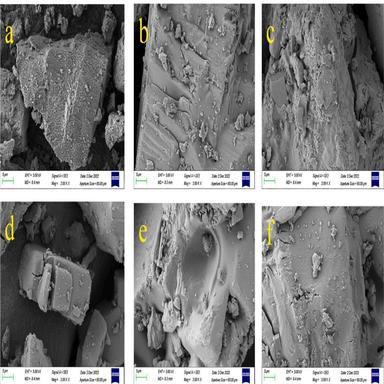
SEM images: (a) BS; (b) BS/1 wt% Al2O3; (c) BS/1 wt% CuO; (d) BS/0.8 wt% Al2O3/0.2 wt% CuO; (e) BS/0.2 wt% Al2O3/0.8 wt% CuO; (f) BS/0.5 wt% Al2O3/0.5 wt% CuO.